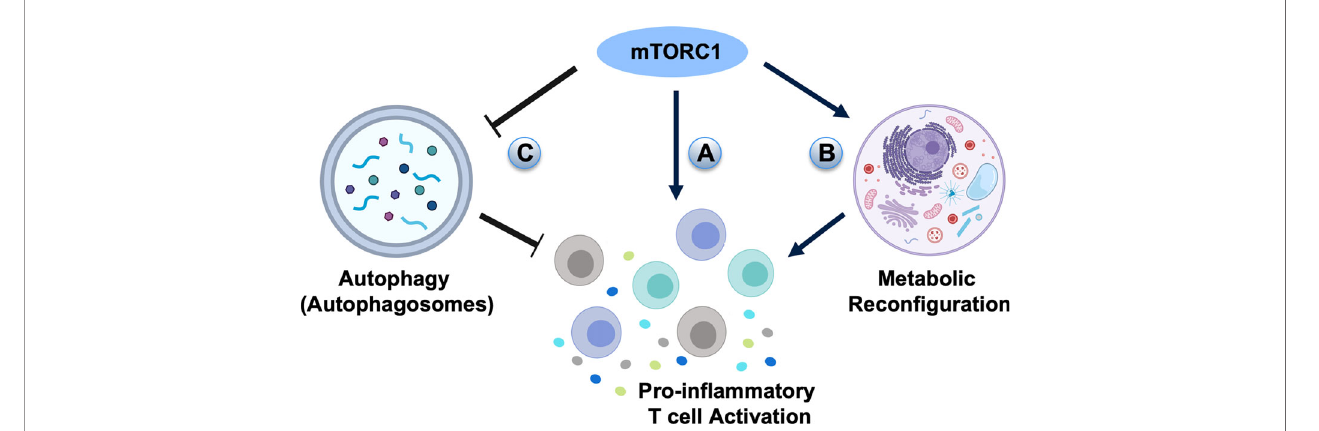
FIGURE 4 | The potential roles of mTOR signaling in the pathogenesis of periodontal diseases. (A) mTORC1 signaling may directly activate pro-in fl ammatory T cell differentiation in periodontal diseases. (B) High mTORC1 activity elevates glycolytic fl ux and generates T cell populations with enhanced effector capacity. (C) As autophagy is inhibited by mTORC1, the negative effect of mTOR signaling on periodontitis may go through autophagic